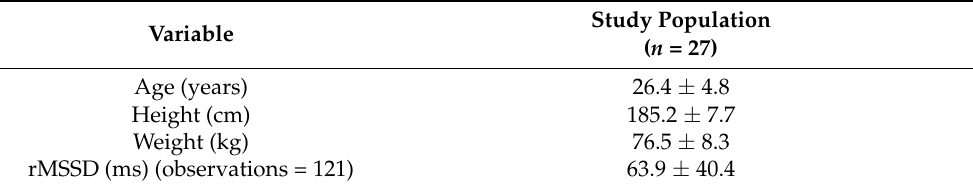
Table 1. Baseline characteristics. Data are presented as mean ± standard deviation. Study population, n = 27. The root of the mean squared differences of successive beat-to-beat intervals (rMSSD) was calculated in 121 observations.